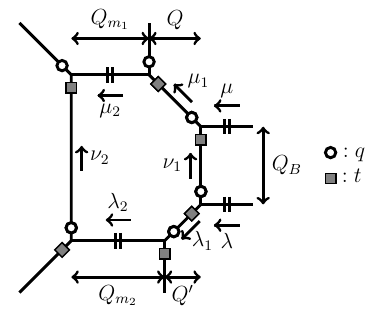
Figure 23 . A 5-brane web for a theory which is S-dual to the SU(2) gauge theory with two (cid:13)avors. The K(cid:127)ahler parameters satisfy Q m